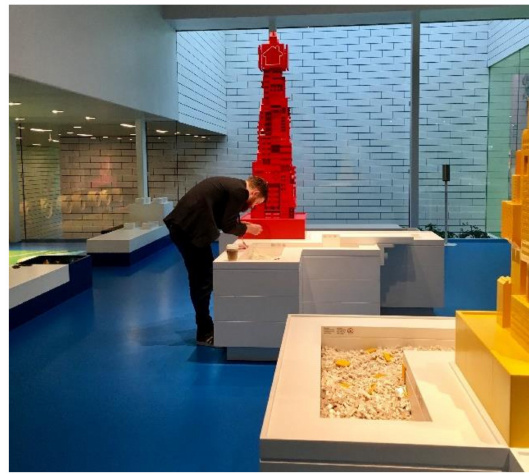
Figure 5. City Architect building